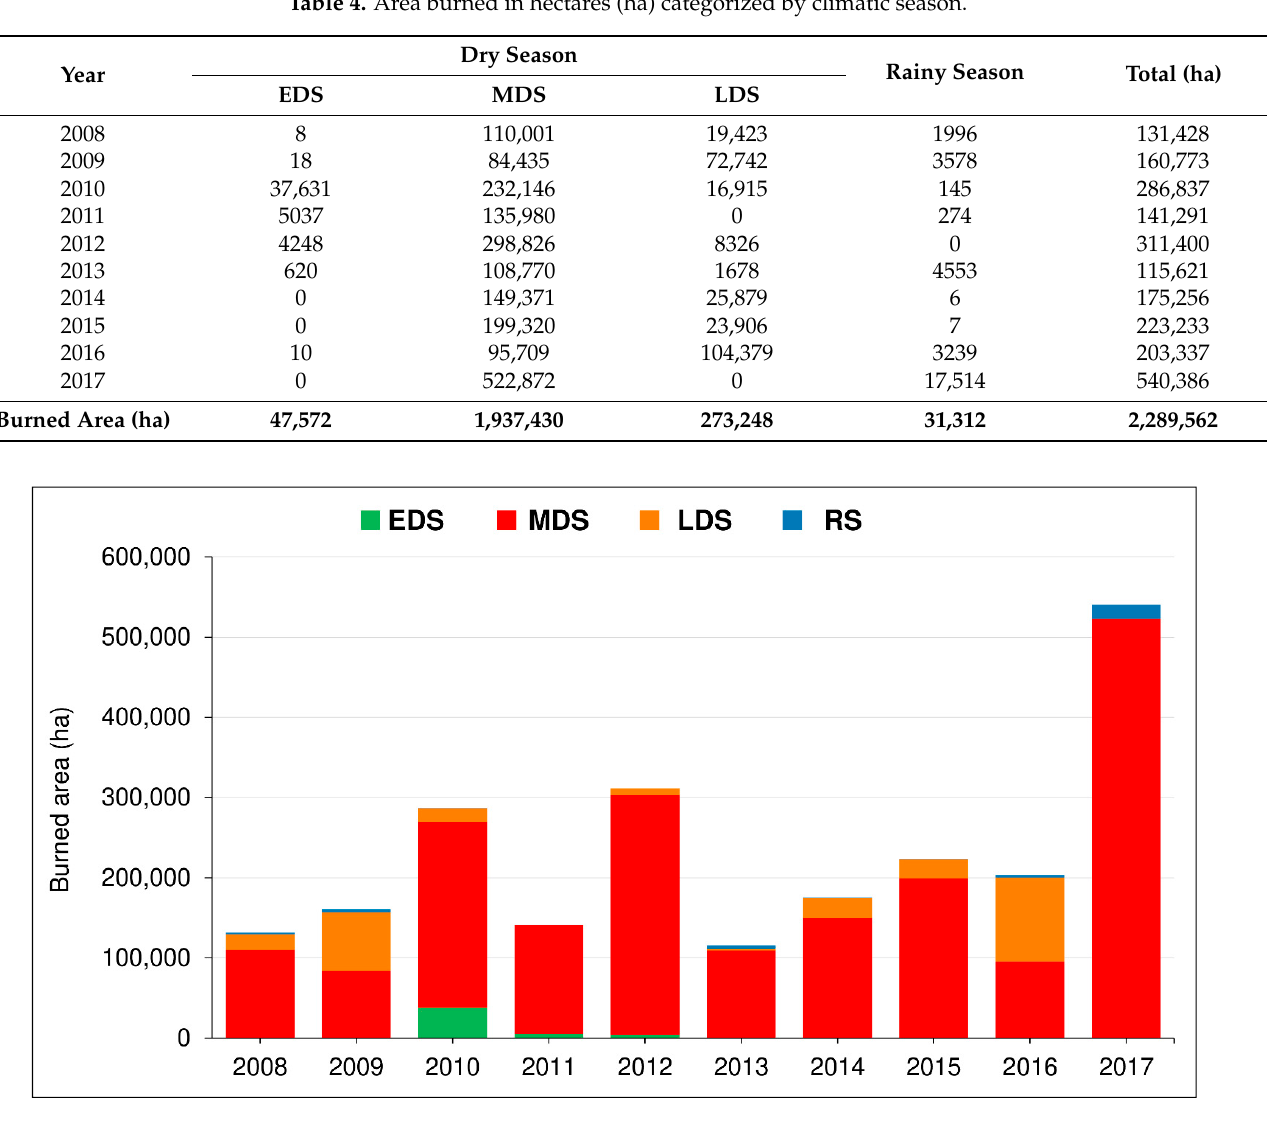
Figure 3. Yearly distribution of burned area from 2008 to 2017 and the linear tendency of increase.